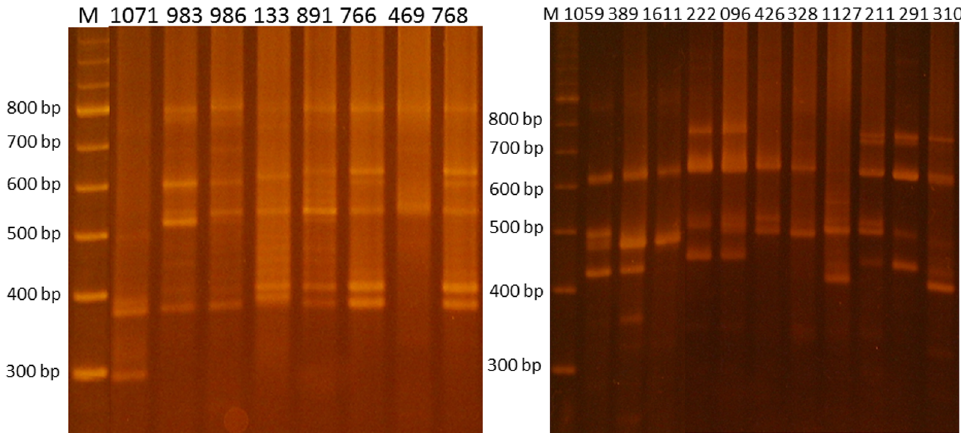
Figure 2. 1.5% agarose gel electrophoresis showing representative LSSP-PCR pro fi les from parasites belonging to clusters I, II and